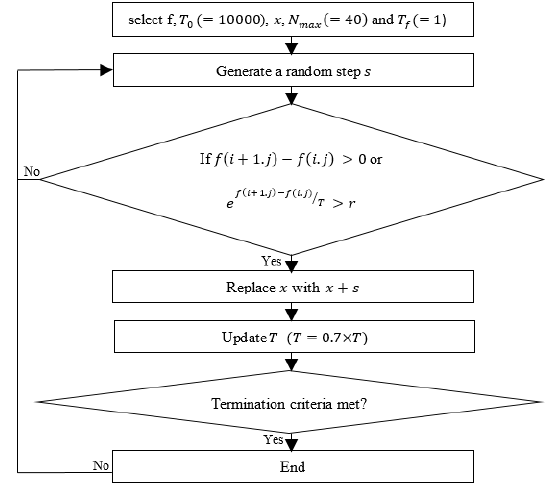
Figure 2 . The flowchart of SA optimization of AMWNVD